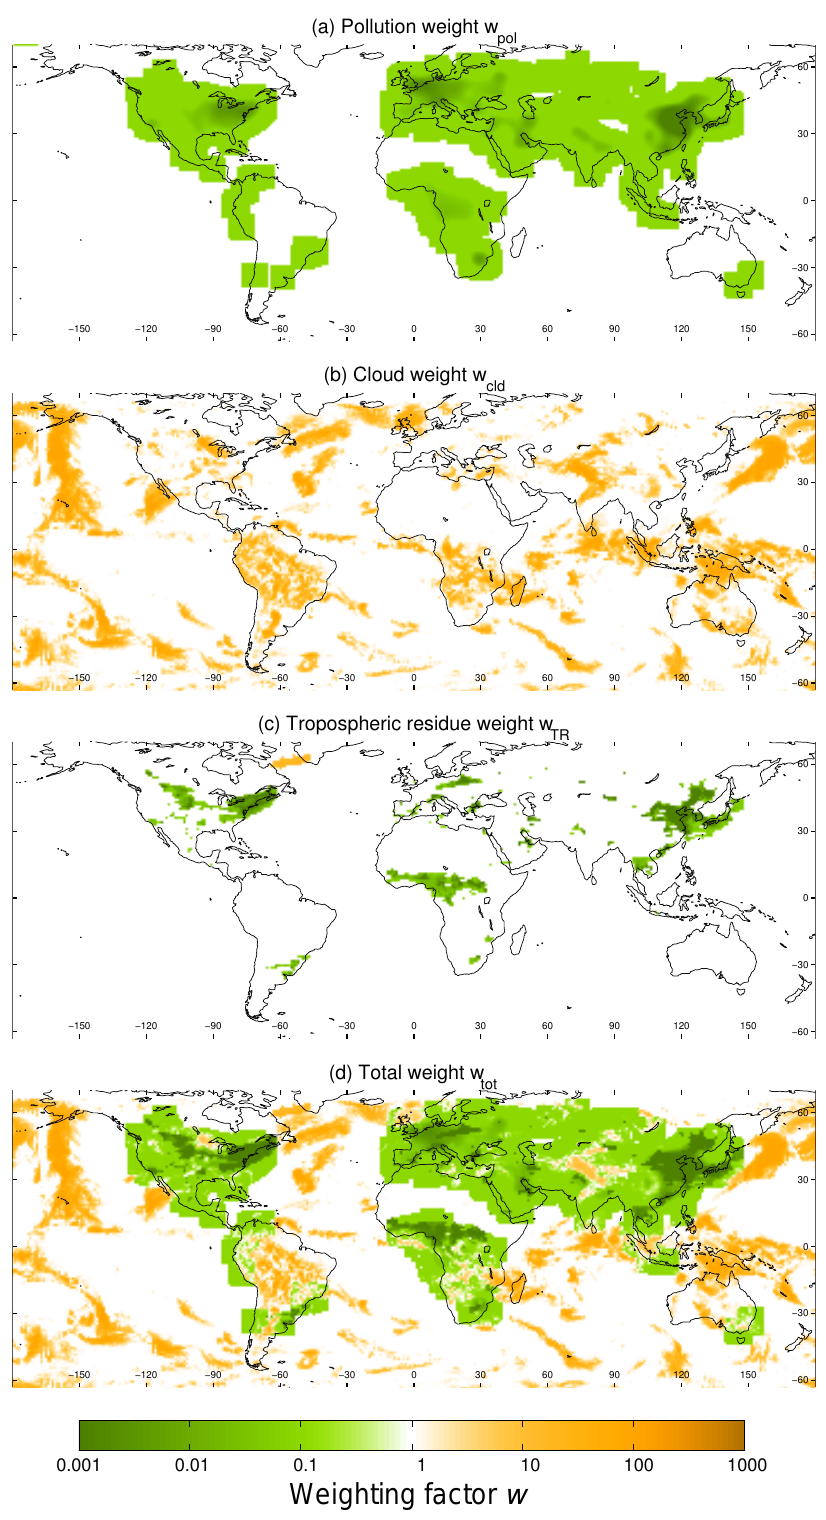
Figure 2. Maps of the weighting factors for 1 January 2005 for OMI: (a) pollution weight w pol , (b) cloud weight w cld , (c) tropospheric residue weight w TR , and (d) product of all weighting factors (Eq.